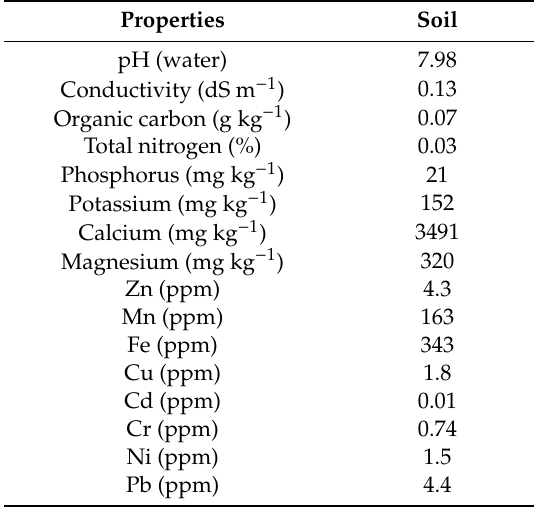
Table 1. Chemical properties of dry soil in the present